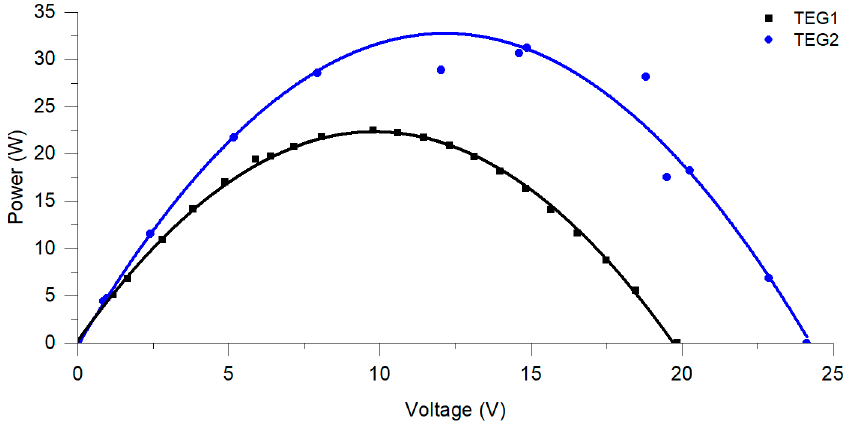
Figure 8. Power–voltage (P–V) characteristics of the tested TEGs.